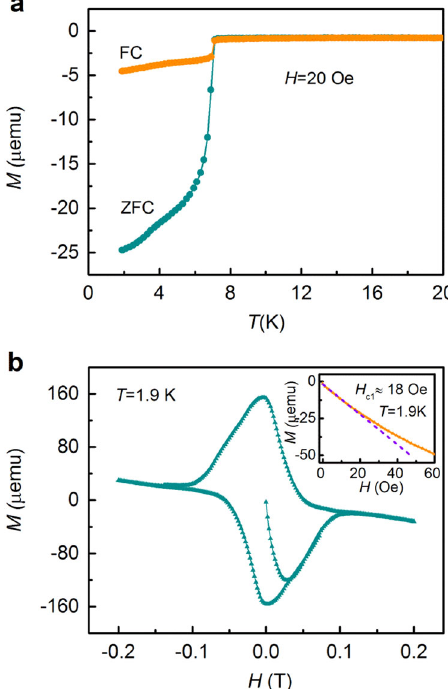
Fig. 2 Magnetization characterizations. a Temperature dependence of the DC magnetization of TiO fi lm in ZFC and FC modes at 20 Oe for H ⊥ (111). The T c is identi fi ed as 7.0 K. b Magnetization vs . magnetic fi eld ( M-H ) at 1.9 K for H ⊥ (111). Inset: H c1 at 1.9 K